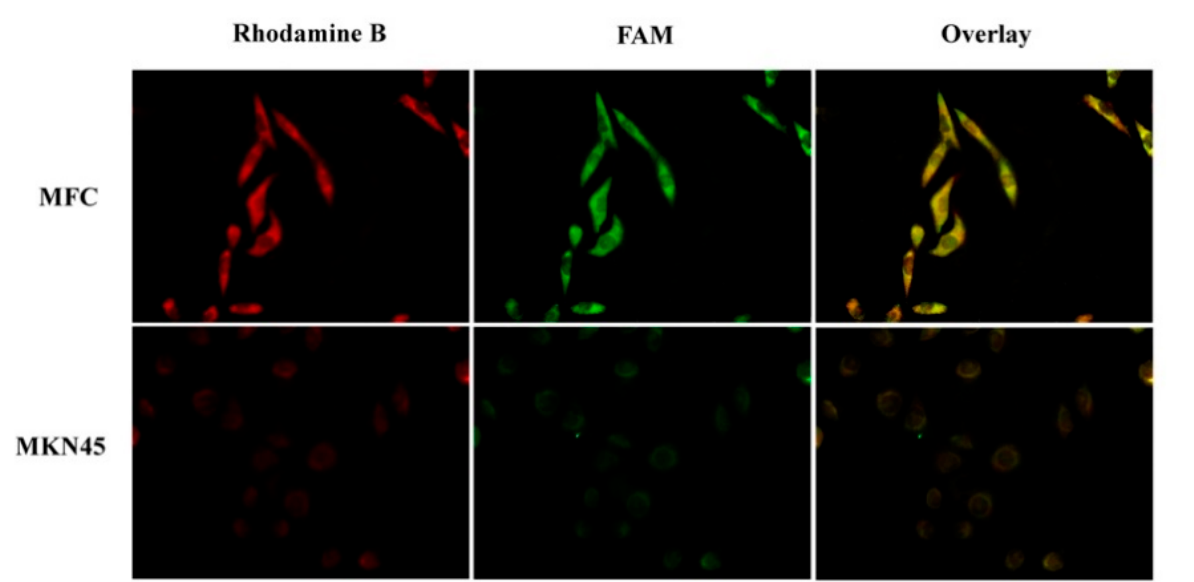
Figure 2. Fluorescent images of siTGF- β 1- α PDL1-PEG-PCL-NPs in MFC and NUGC4 cells. NPs labeled with the fluorescent dye rhodamine B (red) were assessed for cellular uptake. Transfected cells were observed via siTGF- β 1 labeled with FAM (green). Scale bar, 100 µ m (NPs, nanoparticles;